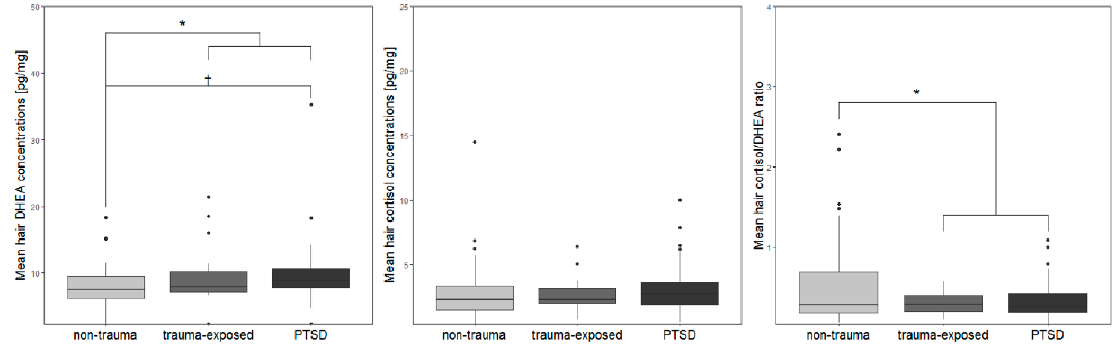
Figure 2. Boxplots of ( A ) DHEA, ( B ) cortisol, and ( C ) cortisol/DHEA ratios from hair samples of the non-trauma, the trauma-exposed and the PTSD participants based on the UCLA PTSD Reaction Index for DSM IV, Child Version.